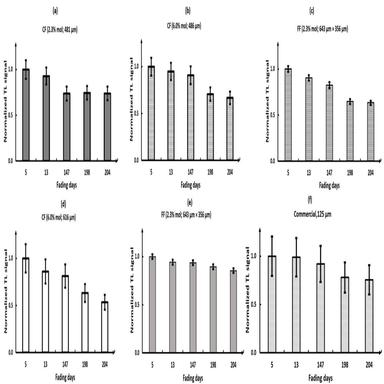
PDD of PTW 31010 IC, all fabricated fibres & Gafchromic™ EBT3 film at different depths.